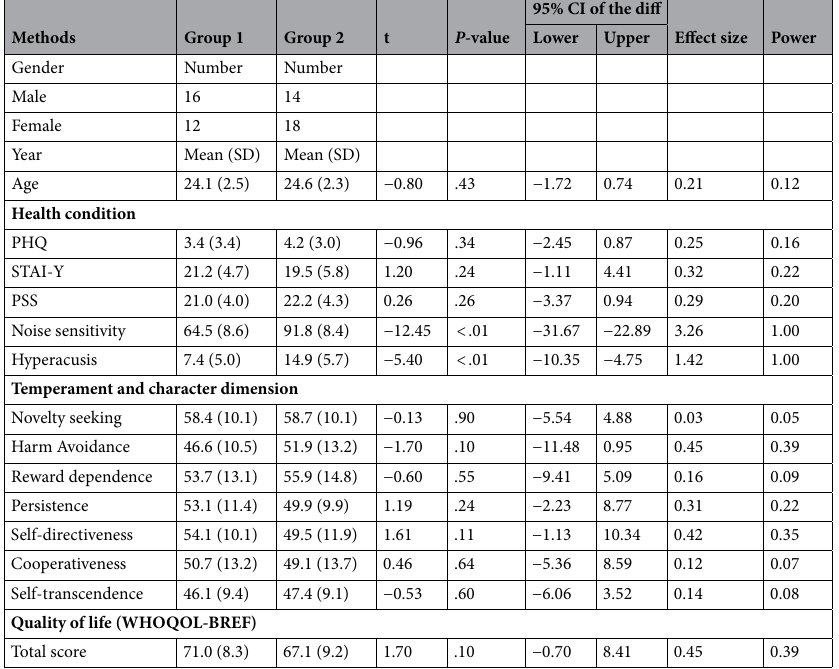
Table 3. Difference of demographic and health condition according to different